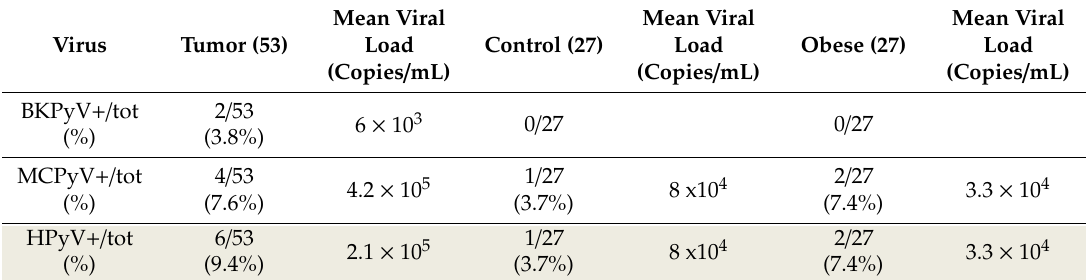
Table 5. HPyVs prevalence among